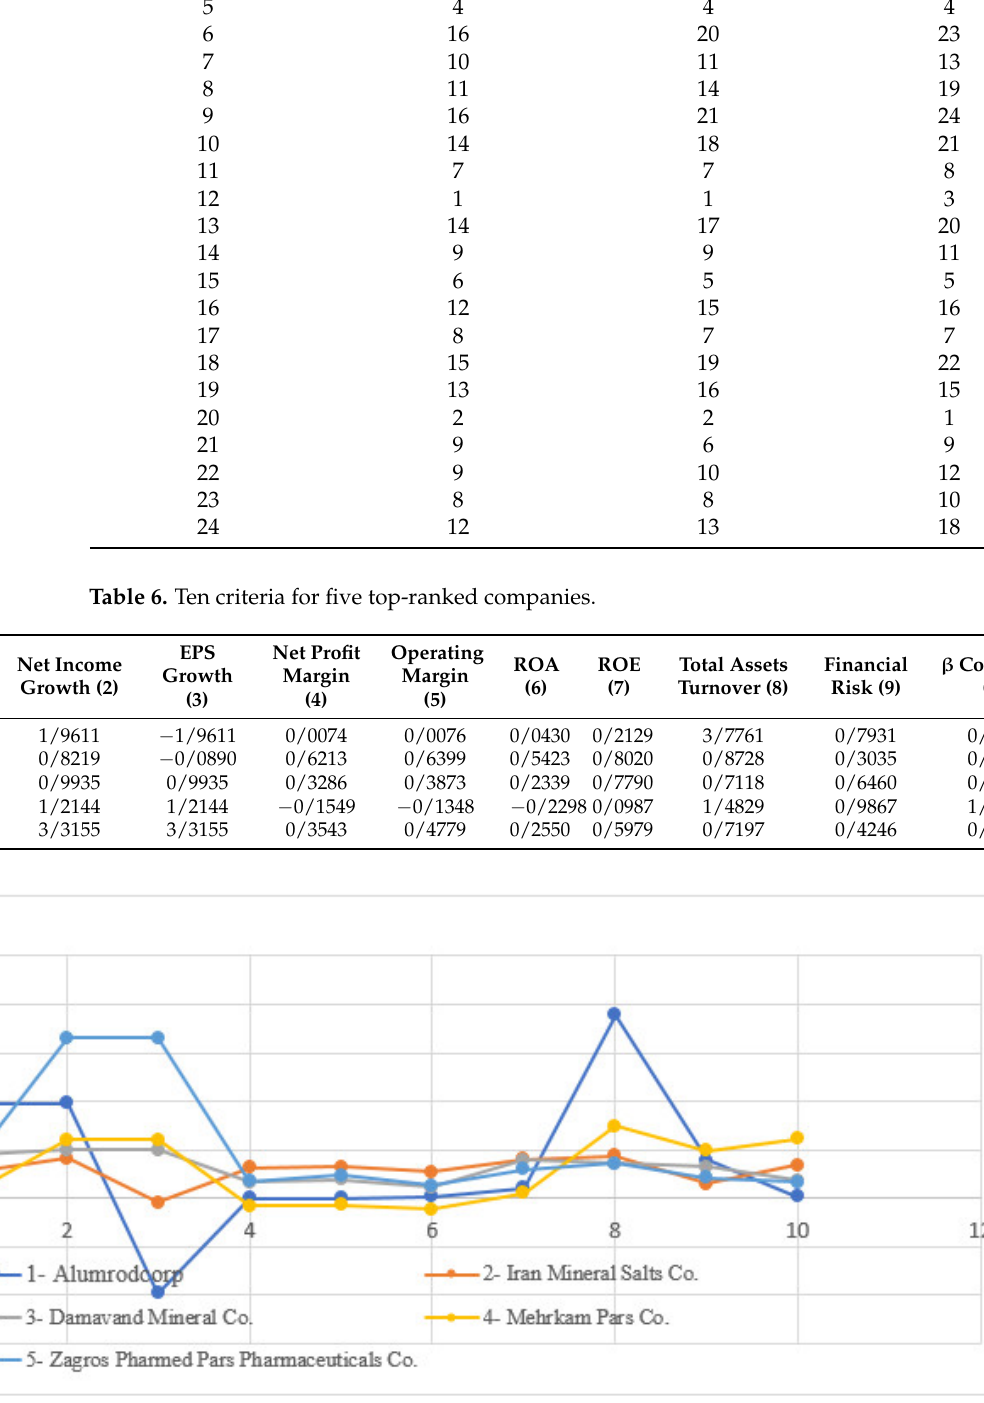
Figure 3. Comparison of 10 criteria for five top-ranked companies.